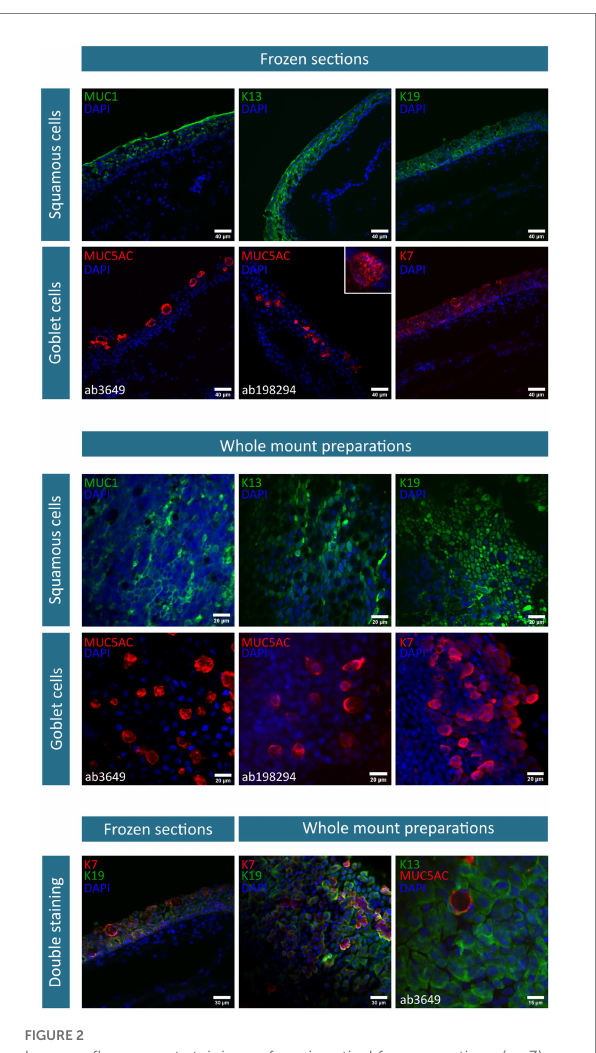
FIGURE 2 Immunofluorescent stainings of conjunctival frozen sections ( n = 3) and whole mount preparations ( n = 2). The investigated markers, along with their corresponding fluorescent label, are summarized per cell type (i.e., squamous epithelial cells and goblet cells) and depicted on each image. Nuclei are counterstained using 4 ′ ,6-diamidino-2-phenylindole (DAPI). As two mucin (MUC) 5AC antibodies are used, specifications are mentioned where necessary. Of note, the illustrative MUC5AC (ab198294) and K13/MUC5AC staining is exceptionally performed on one donor. K,